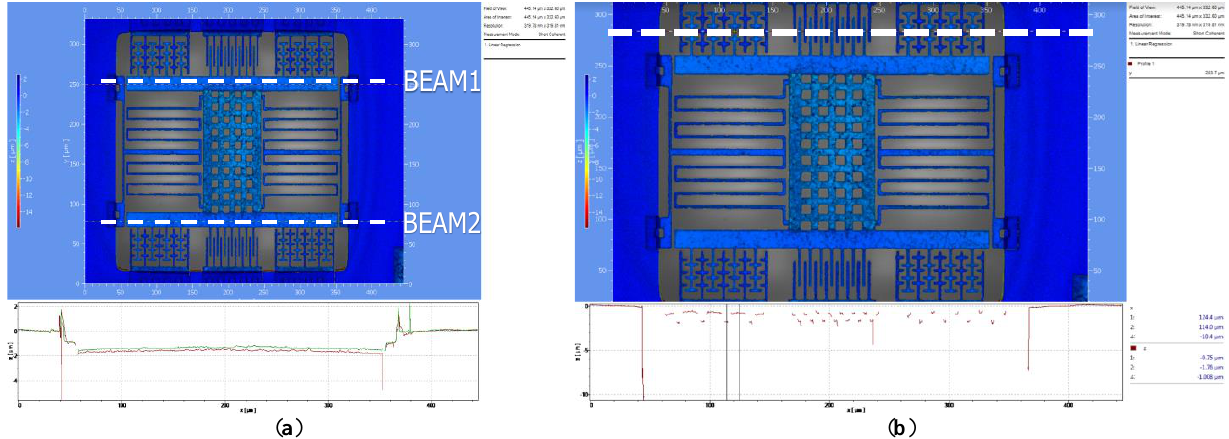
Figure 14. White light interferometry (WLI) view of ( a ) structure along beams on two sides and ( b ) structure along stator and rotor.